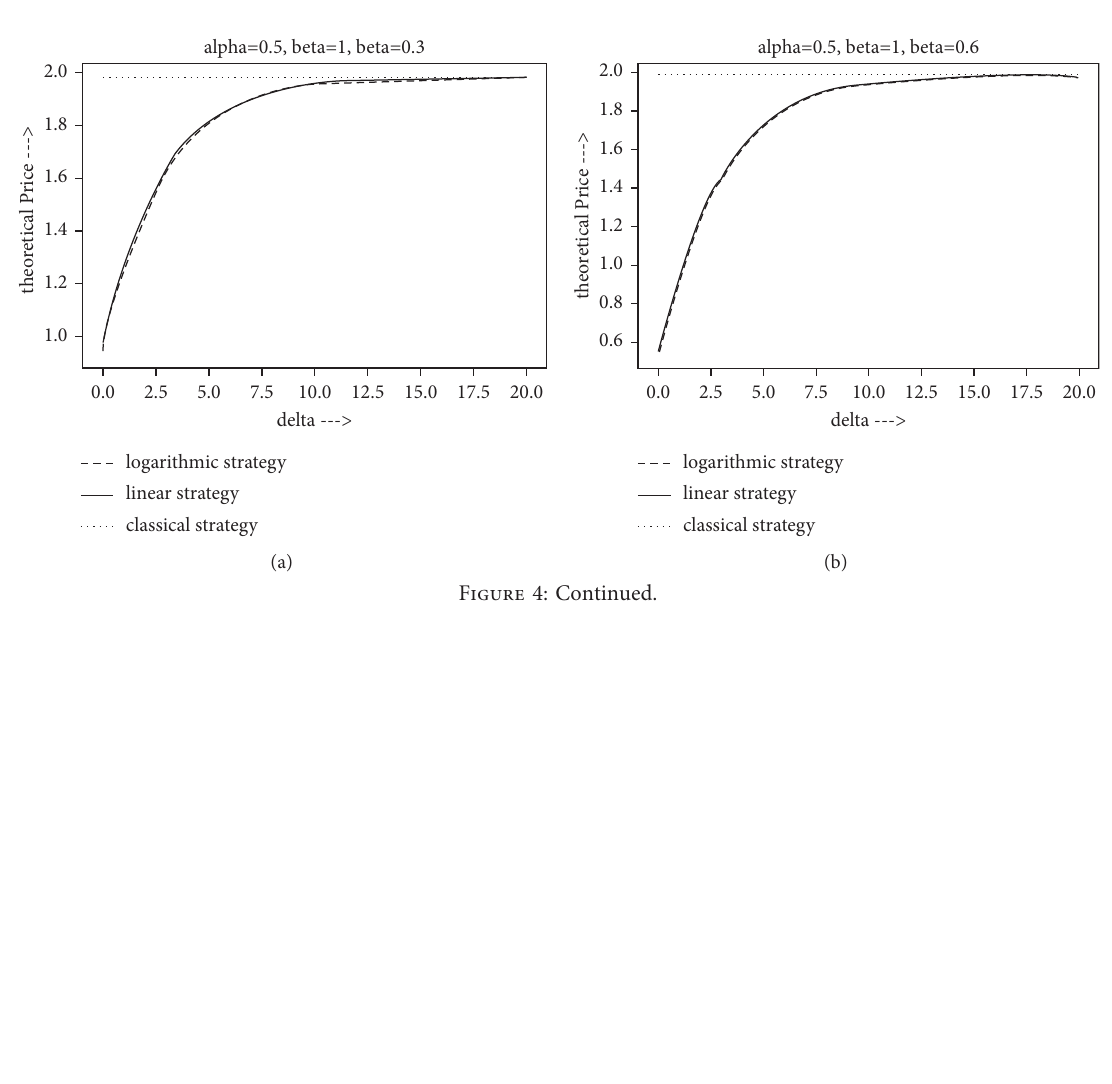
Figure 3: The theoretical price as a function of α when δ � 0, β � 1, and β